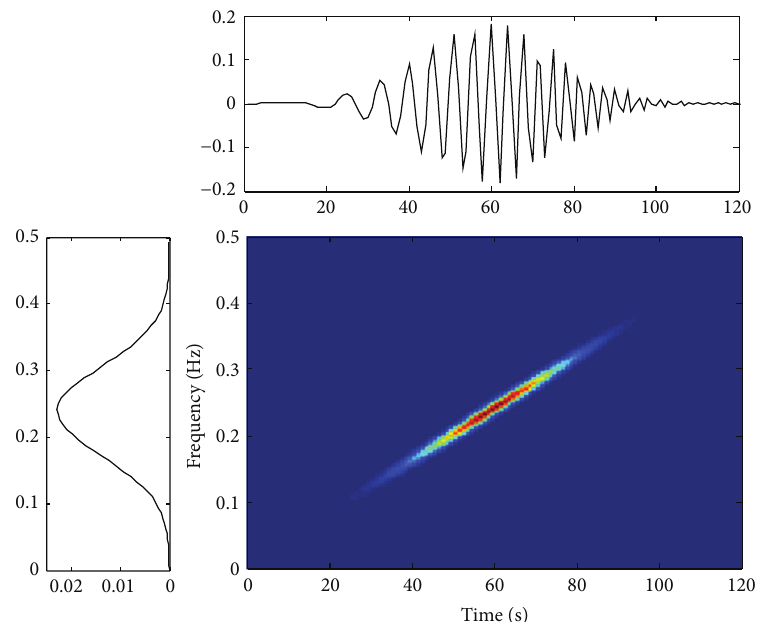
Figure 2: Chirplet and its Wigner-Ville